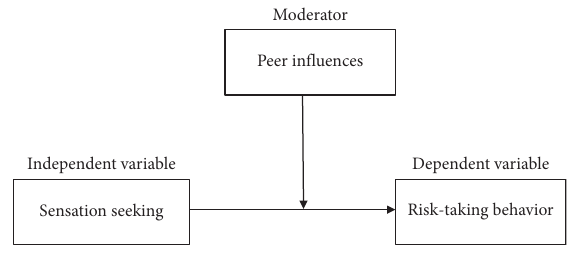
Figure 1: Hypothesized model of research showing sensation seeking as IV, peer influences as moderator, and risk-taking be- havior as DV [17]. Table 1: Descriptive, frequencies, and percentage of demographic variables ( N �